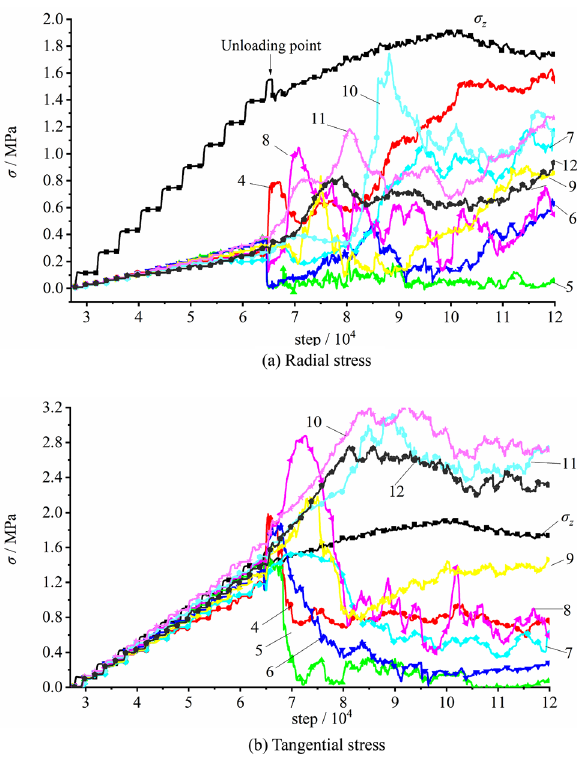
Figure 27. The stress variation of the measuring element at the vertical sidewall during excavation with imposed vertical stress of 1.500